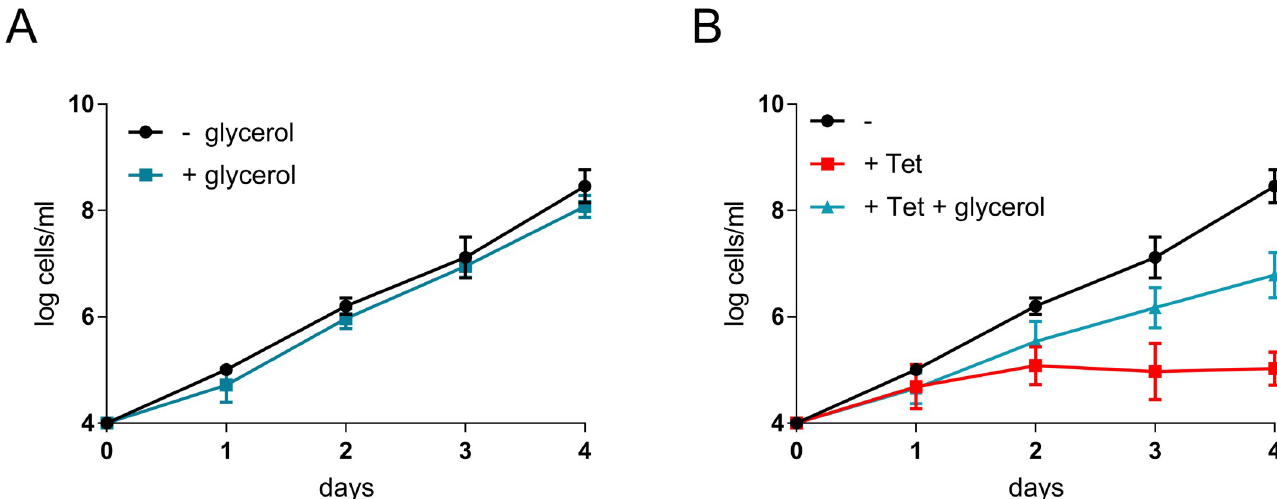
Fig 3. Glycerol rescues bloodstream form trypanosomes lacking glucose transporters. (A) Growth curve showing impact of glycerol without hexose transporter knockdown. Addition of 5 mM glycerol triggers non-significant, but consistent mild growth defect. Data points are means of two independent experiments with two biological replicates. Error bars, SD. (B) Growth curve showing impact of glycerol on THT1/THT2 knockdown cells. 5 mM glycerol partially rescues the knockdown-associated growth defect. Data points are means of two independent experiments with two biological replicates. Error bars, SD.